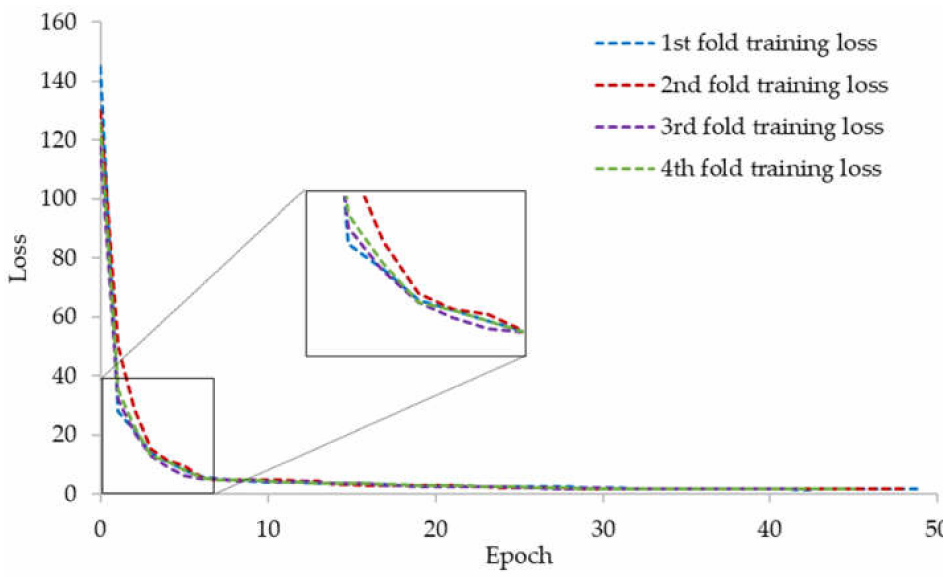
Figure 12. Training loss of YOLOv3 on the combined multinational dataset of the four currency types.